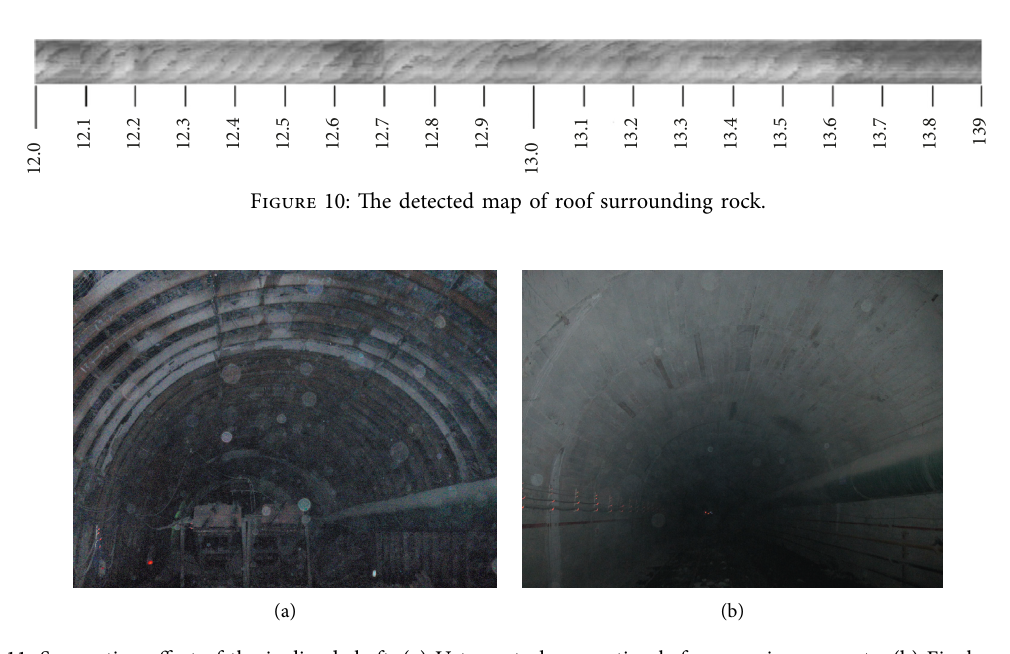
Figure 11: Supporting effect of the inclined shaft. (a) U-type steel supporting before pouring concrete. (b) Final